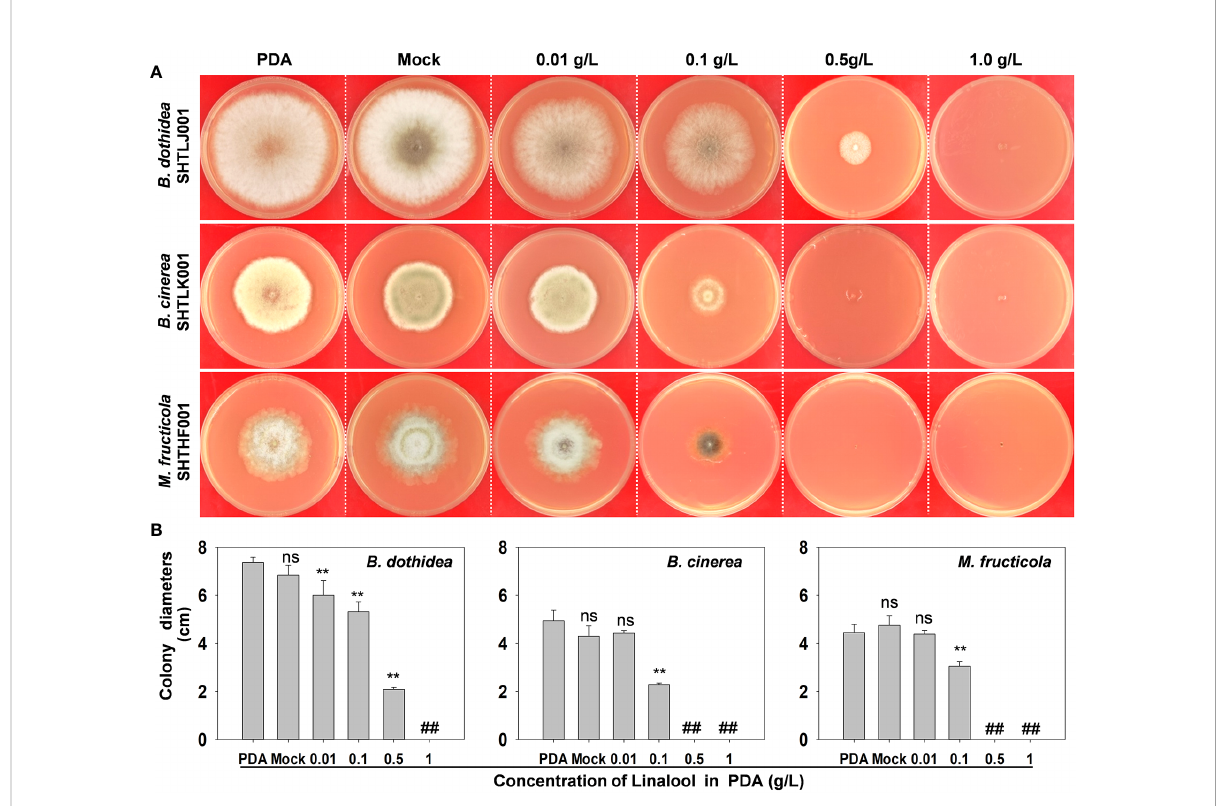
FIGURE 7 Antifungal activities of linalool in PDA medium. (A) Representative photographs show the growth of three pathogens on the PDA mediums containing different concentrations of linalool at 3 days post inoculation. (B) Statistic of the colony diameters of three pathogens on PDA mediums at 3 days post inoculation. The asterisks denote that the colony diameters of each pathogen in those PDA mediums containing linalool were signi fi cantly lower than that in PDA mediums without ethanol (Mock) and linalool ( p <0.05), ‘ ## ’ indicates no data were obtained and ‘ ns ’ means the difference was not signi fi